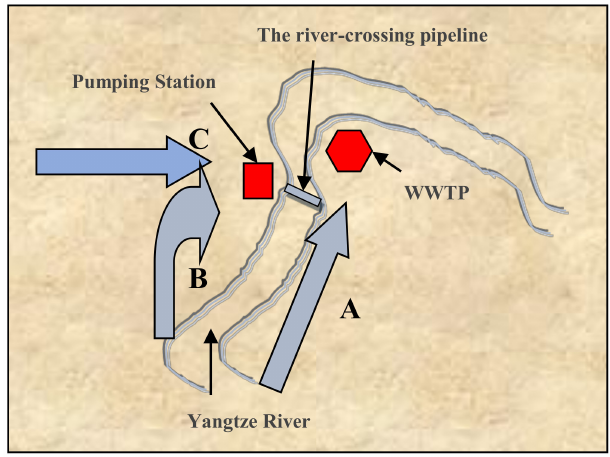
Figure 1. The wastewater collection route. WWTP, wastewater treatment